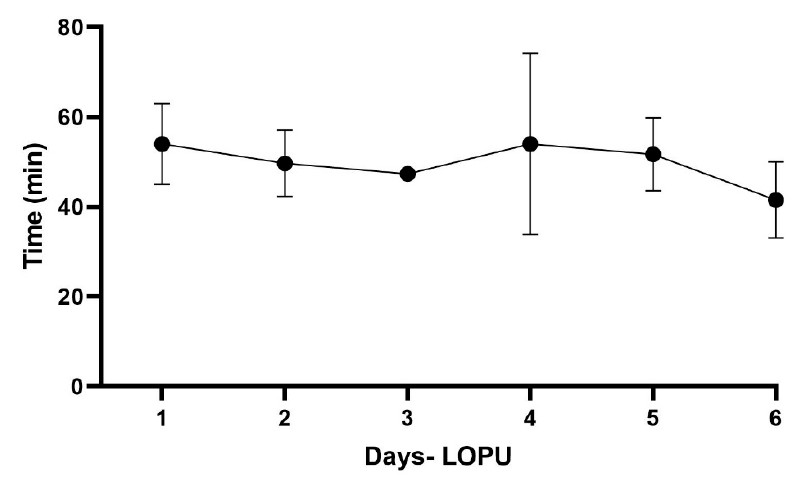
Figure 9. Graphic demonstration of the learning curve of laparoscopic follicular aspiration in buffalo calves. Each point represents the average time involving three procedures/day.